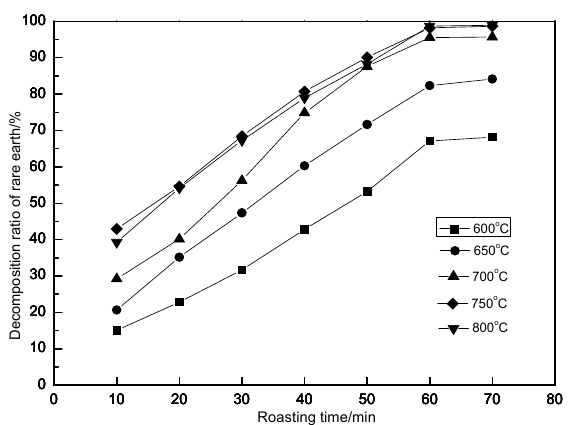
Figure 4. Effect of roasting time on the decomposition rate of REE at different roasting temperatures.